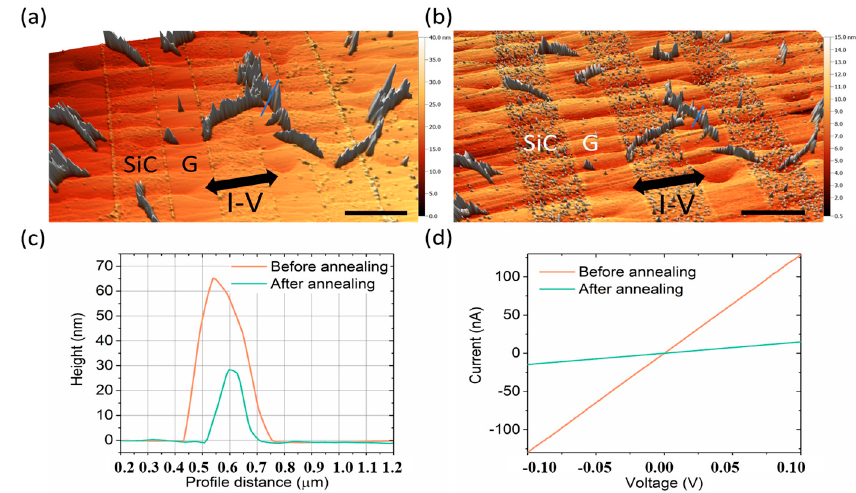
Figure 3. Characterization of graphene-nanofiber devices before and after the thermal annealing step. ( a ) Atomic force microscopy (AFM) topography image of G/SiC electrodes contacting polyaniline (PANI) nanofibers, where graphene leads are indicated by G.; ( b ) AFM topography image of ( a ) after thermal annealing at T = 800 ° C. The graphene leads remain intact and morphology of PANI nanofibers are preserved. Scale bar: 2 μ m; ( c ); The reduction in size of PANI nanofibers after annealing is compared in the AFM height profile of the region indicated by blue lines in ( a , b ). Both the width (320 nm to 190 nm) and height (65 nm to 28 nm) are reduced after annealing; ( d ) I-V characteristics of the adjacent graphene electrodes before and after annealing. Between the two electrodes in which I-V was measured, three PANI nanofibers are contacted in total (Device G4, see Figure S7). After annealing, the resistance typically increases to 10 times.